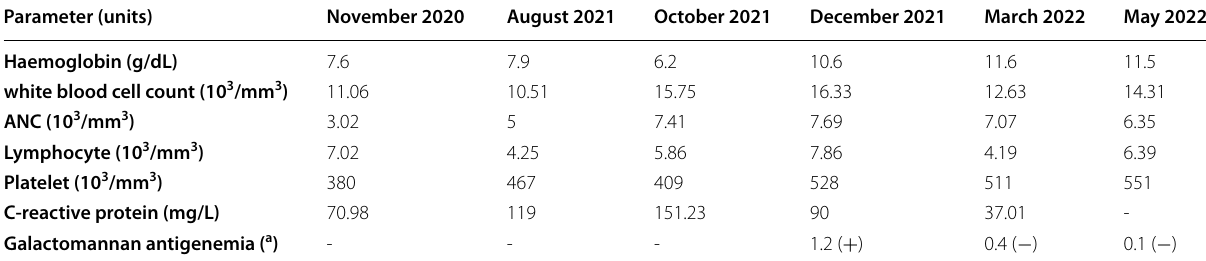
a The results are presented as an optical density (OD) index. According to the manufacturer’s instructions, sera with an index